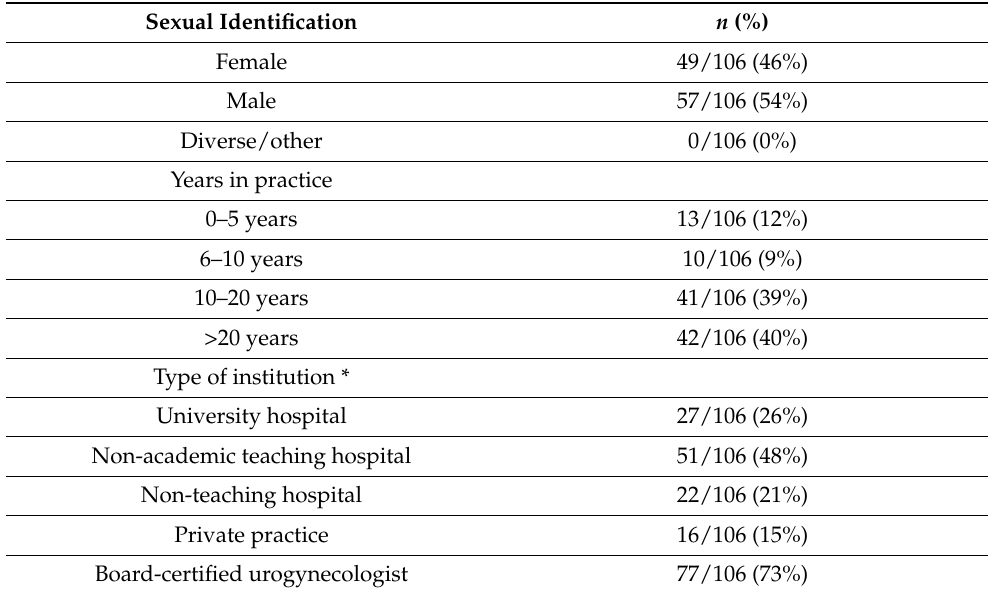
Table 1. Characteristics of respondents. * Cumulative percentage can be more than 100% because participants were allowed to give more than one